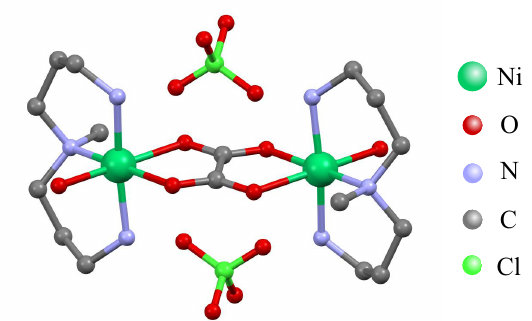
Figure 6. A crystal structure of the dinuclear nickel complex [Ni 2 (Medpt) 2 ( µ -ox)(H 2 O) 2 ](ClO 4 ) 2 · 2H 2 O abbreviated as NAOC (ox = oxalate and Medpt = 3,3 (cid:48) -diamino-N-methyl-dipropylamine) adapted according to crystallographic data reported in reference [48]. A color scheme for the atom labeling is shown in the legend, whereas hydrogen atoms are not shown for